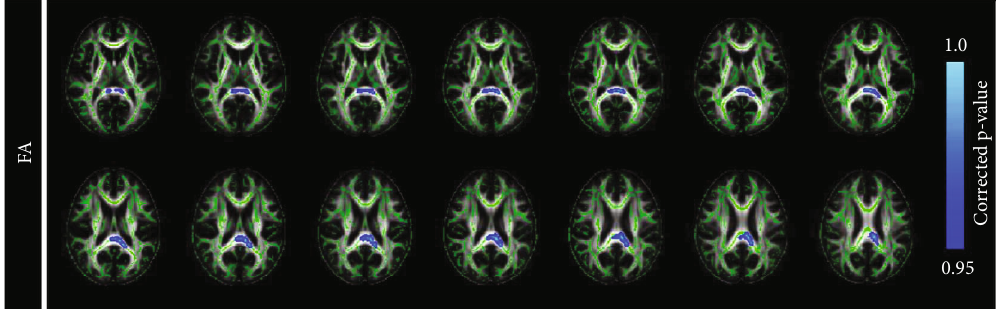
Figure 3: Tract-based spatial statistics maps are shown the FA di ff erences between the two groups, and blue represents regions with signi fi cantly decreased FA in LDH patients, compared with